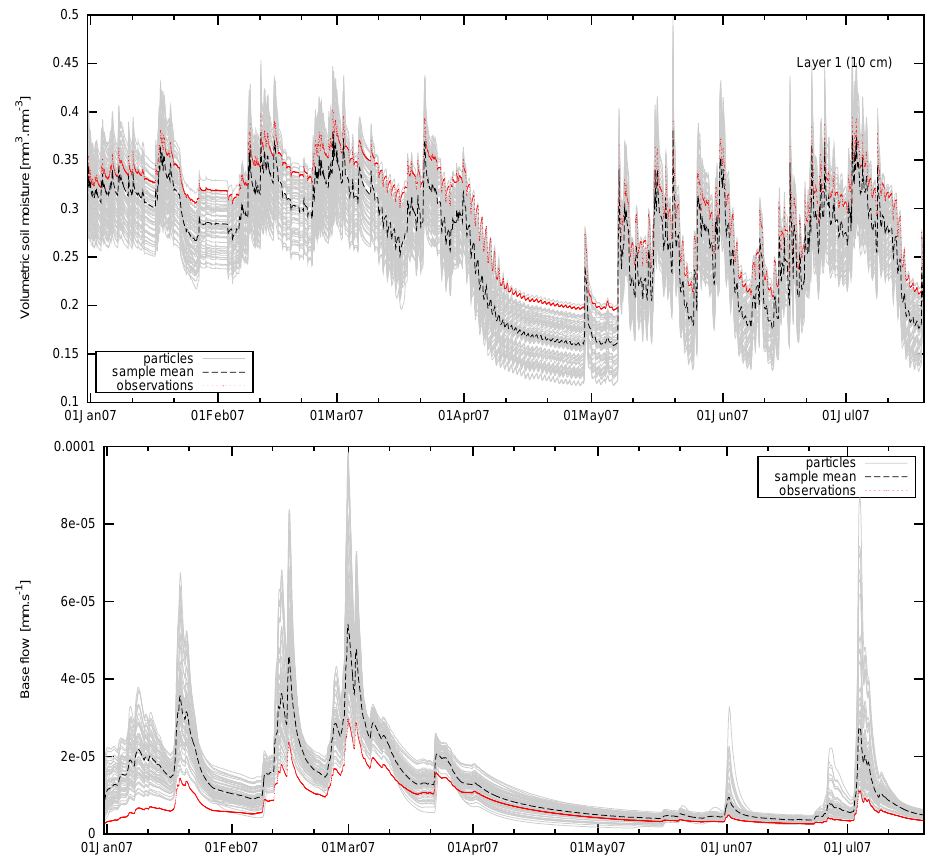
Fig. 4. Soil moisture and baseflow ensembles: The upper plot corresponds to the generation of the volumetric soil moisture ensemble with the ensemble members in gray line, the ensemble mean in black line and the synthetic soil moisture observations in red dotted line. The lower plot corresponds to the baseflow ensemble.